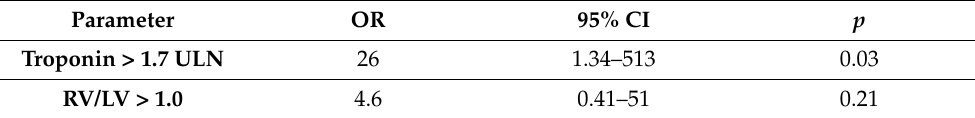
Table 3. Univariable predictors of SAE in sPESI 0 points APE patients.